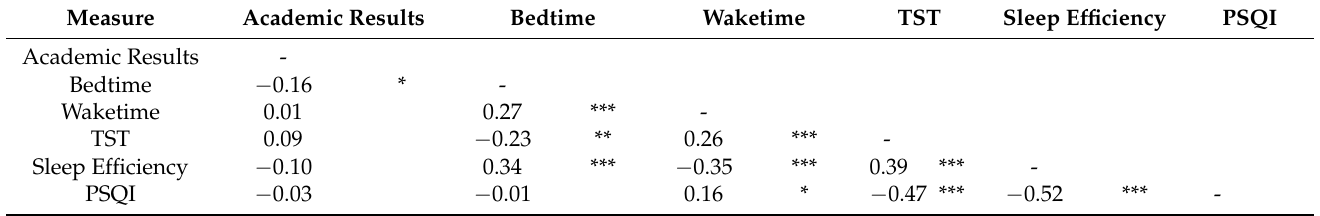
Table 2. Spearman correlation matrix between academic grade results and sleep variables,